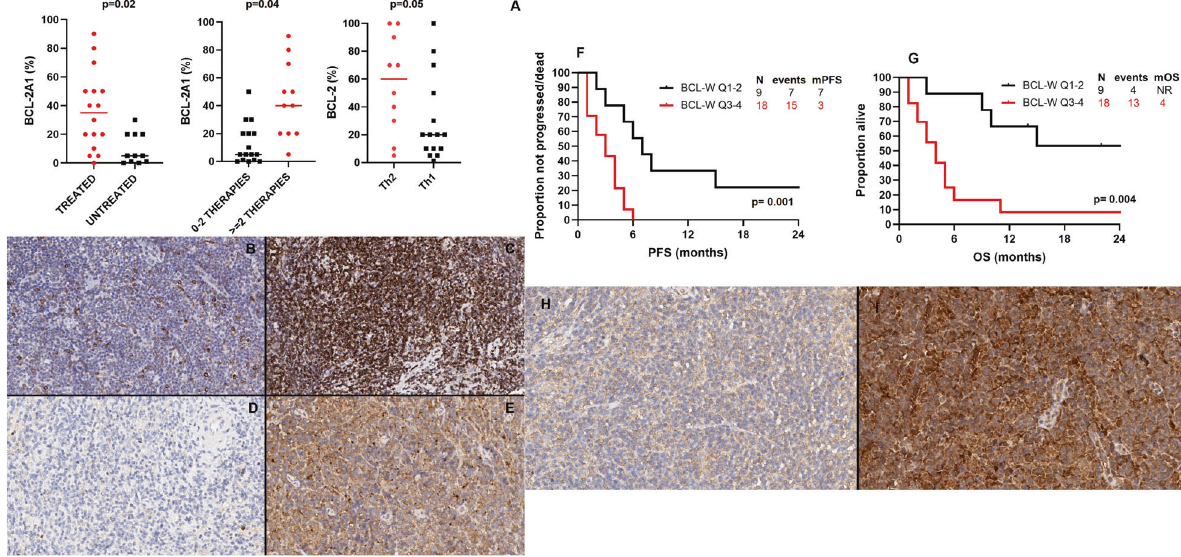
Fig. 1 Association between BCL-2 family proteins expression and baseline characteristics, and survival according to BCL-W expression. A Association between BCL-2A1 levels and previous therapy, and BCL-2 lvels and Th2 phenotype. B BCL-2 immunostain shows strong positivity in only 10% of lymphoma cells (low expression). C BCL-2 immunostain shows strong expression in 100% of lymphoma cells (high expression). D BCL-2A1 immunostain shows negativity in all lymphoma cells (low expression). E BCL-2A1 immunostain shows diffuse and moderate to strong cytoplasmic expression in 80% of lymphoma cells (high expression). F Progression-free survival according to BCL-W expression. G Overall survival according to BCL-W expression. H BCL-W immunostain shows weak cytoplasmic positivity in 40% of lymphoma cells (low expression). I BCL-W immunostain shows diffuse and intense expression in 100% of lymphoma cells (high